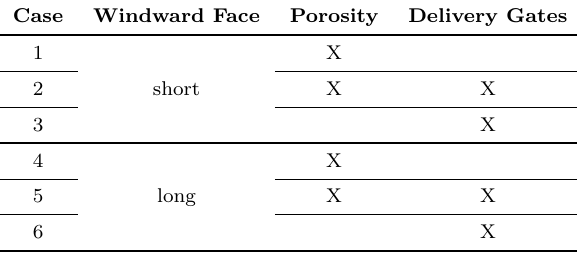
Figure 8. (a) The minimal c direction west (on long face) and (b) of all measured flow directions.